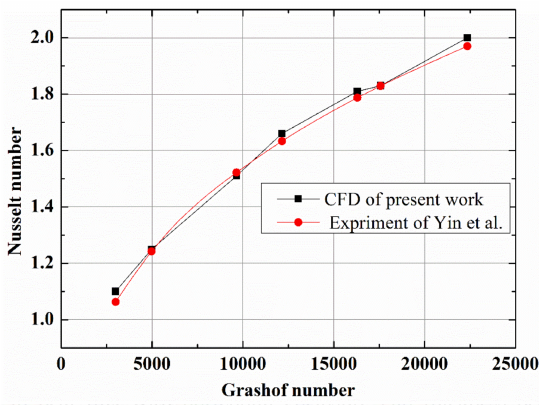
Figure 3. Comparison of the Nusselt numbers between the present study and the literature